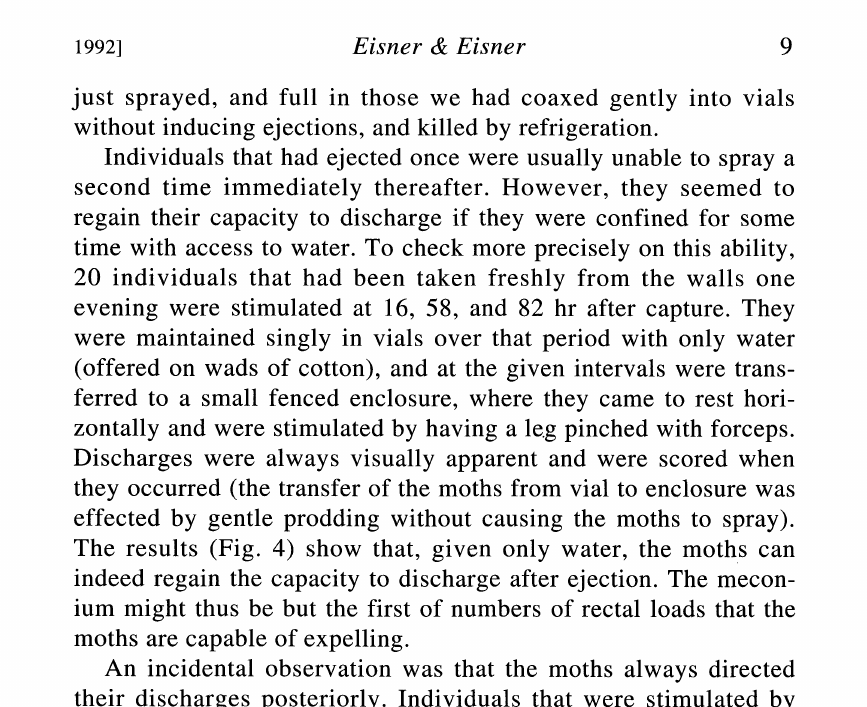
Fig 3. (Top) Dissected abdomen of male E. auxiliaris, showing rectal sac from which spray is ejected. Arrow denotes anal turret. Large quantities of fat body were removed to expose the sac. (Bottom left) Pattern of spray droplets left on wall of vial in which a moth was induced to discharge. (Bottom right) Parallel array of microcapillary tubes (1.5 mm outer diameter), laden with discharged fluid from individual moths. Note variability in turbidity and particulate content. Reference bars: top 2 mm; bottom left 5